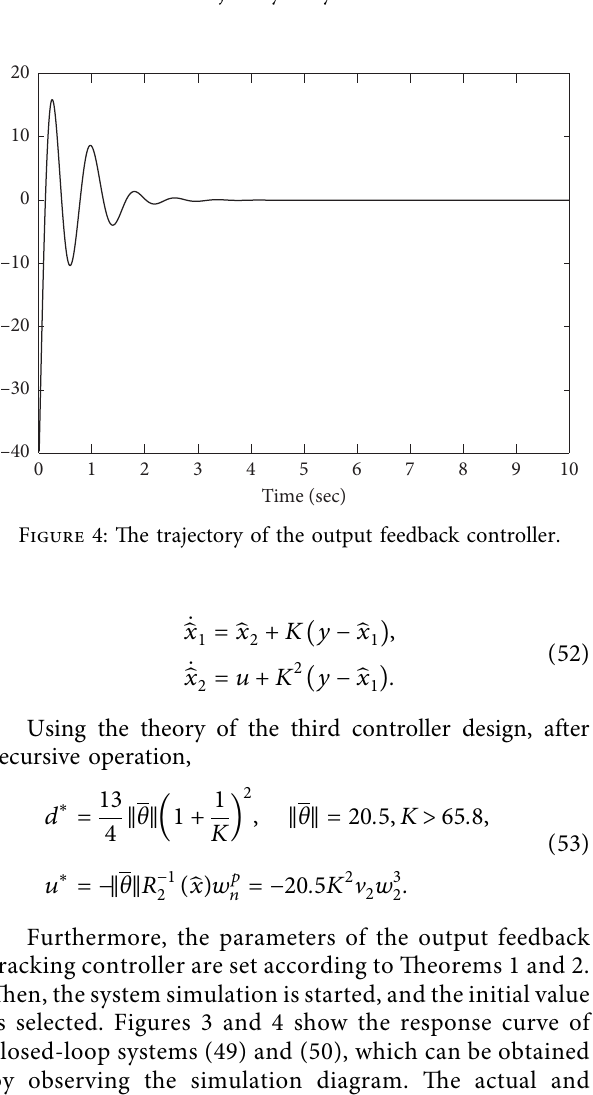
Figure 3: The trajectory of system observer